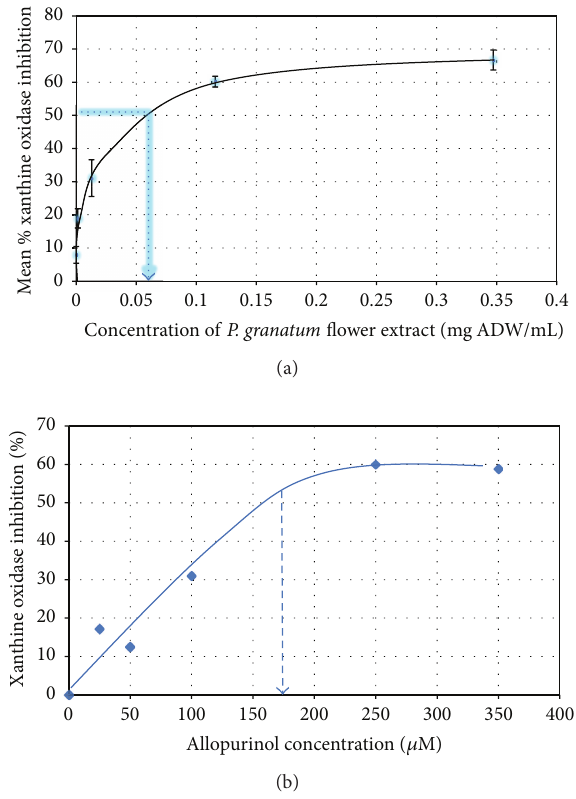
Figure 4: Dose-dependent xanthine oxidase inhibitory activity of pomegranate flower extract and allopurinol. ADW: air dry weight. Data are representative of mean ± standard deviation of three replicates. IC 50 value was extrapolated from the graph.